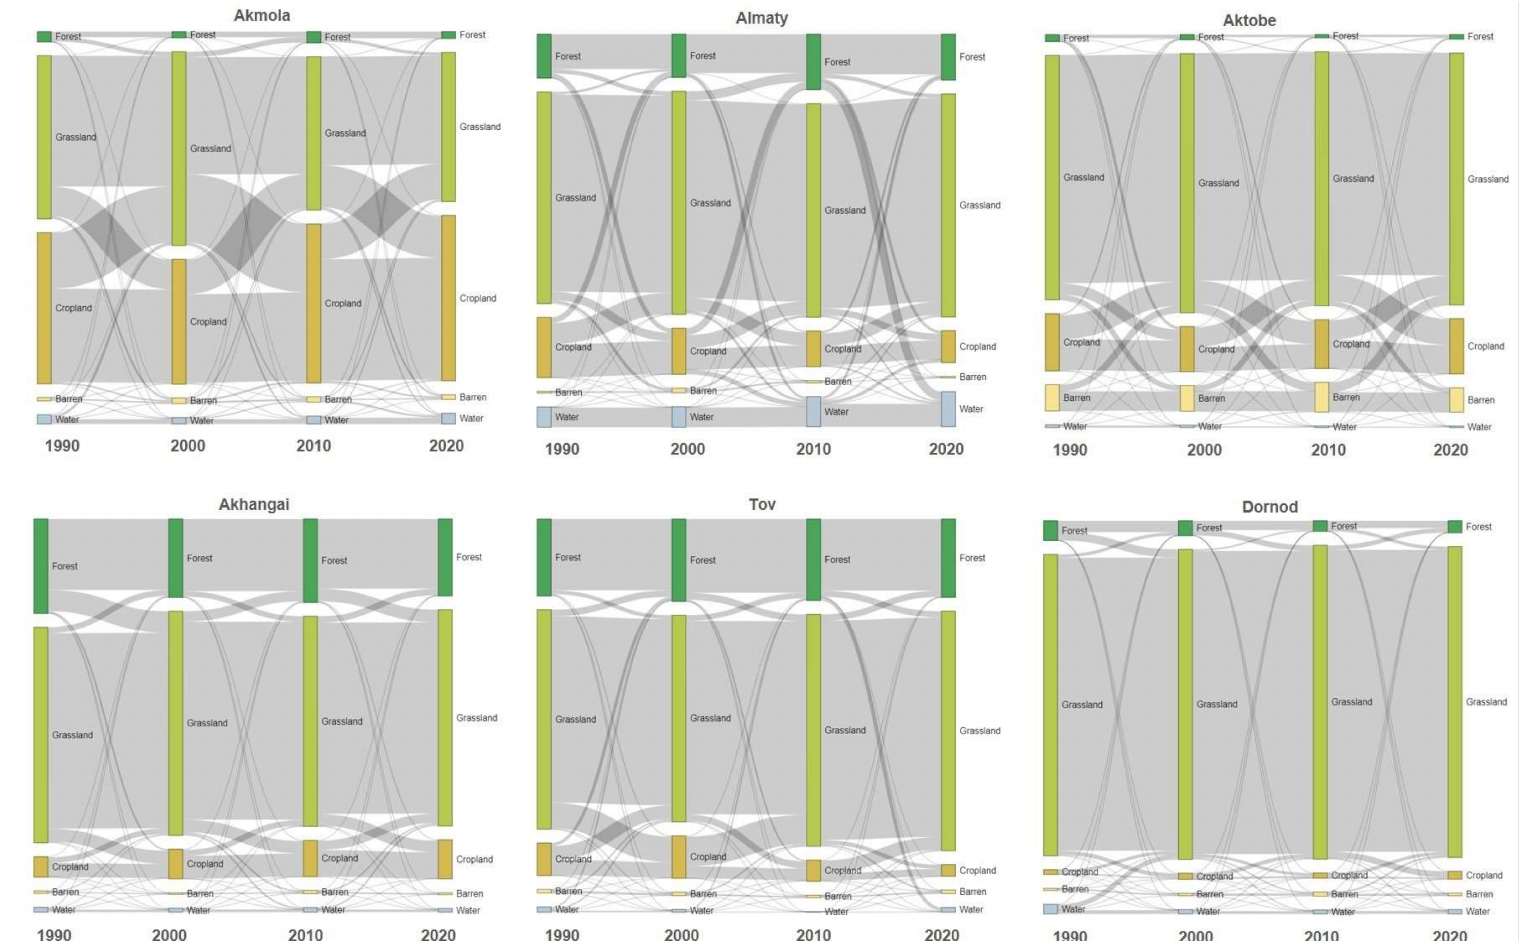
Figure 3. Sankey diagram of land cover conversions from 1990 to 2020 for six provinces. Land cover change in area (km 2 ). (Visit data section on project website for interactive figures http://lees.geo.msu.edu/research/FEW_MK.html accessed on 20 February